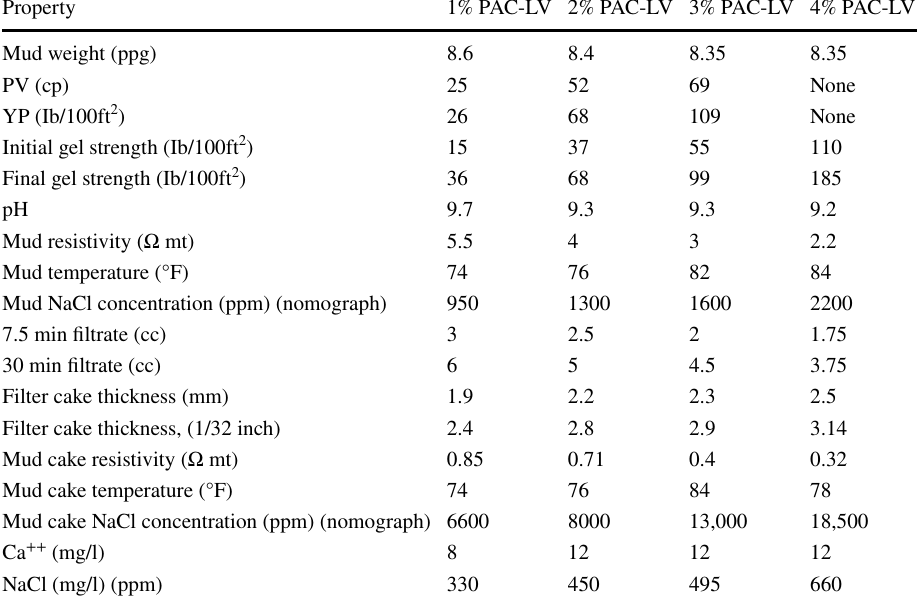
Table 3 The results of adding various concentrations of PAC-LV on the properties of reference fluid